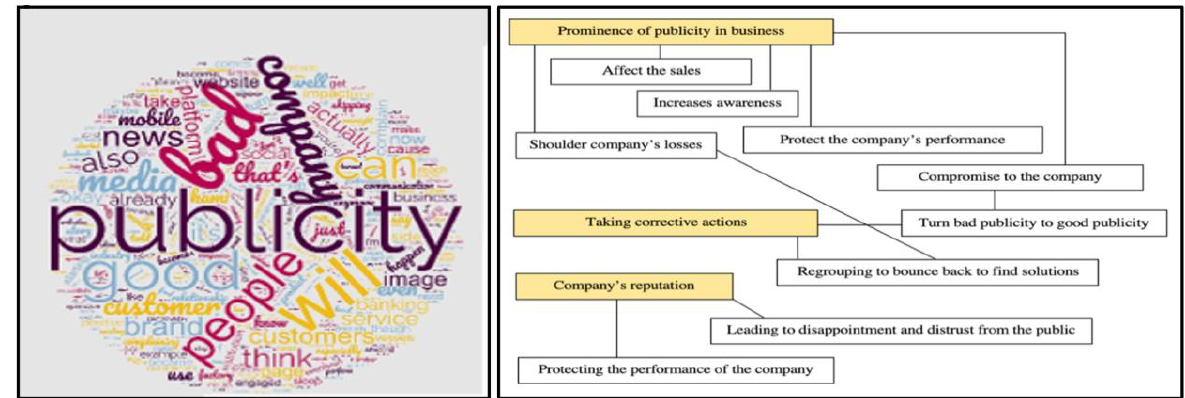
Figure 17: Impact of Good or Bad Publicity to Business